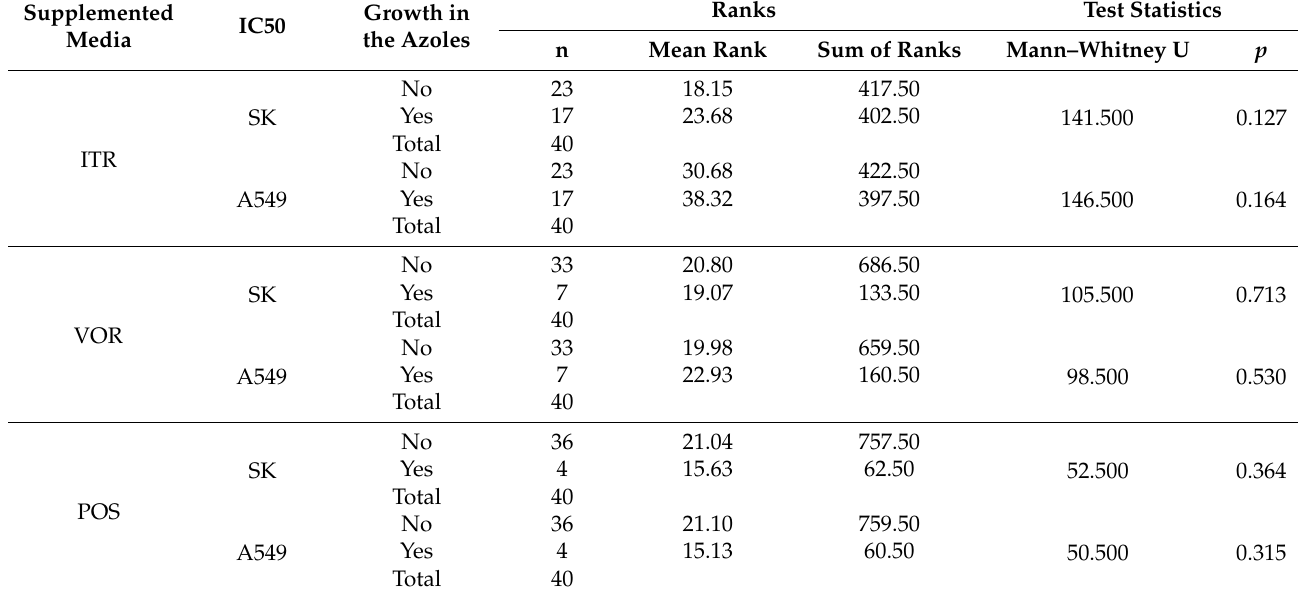
Table 8. Comparison of IC50 levels (SK and A459 cells) between growth on azoles (No/Yes) in ITR, VOR, and POS media. Mann–Whitney test